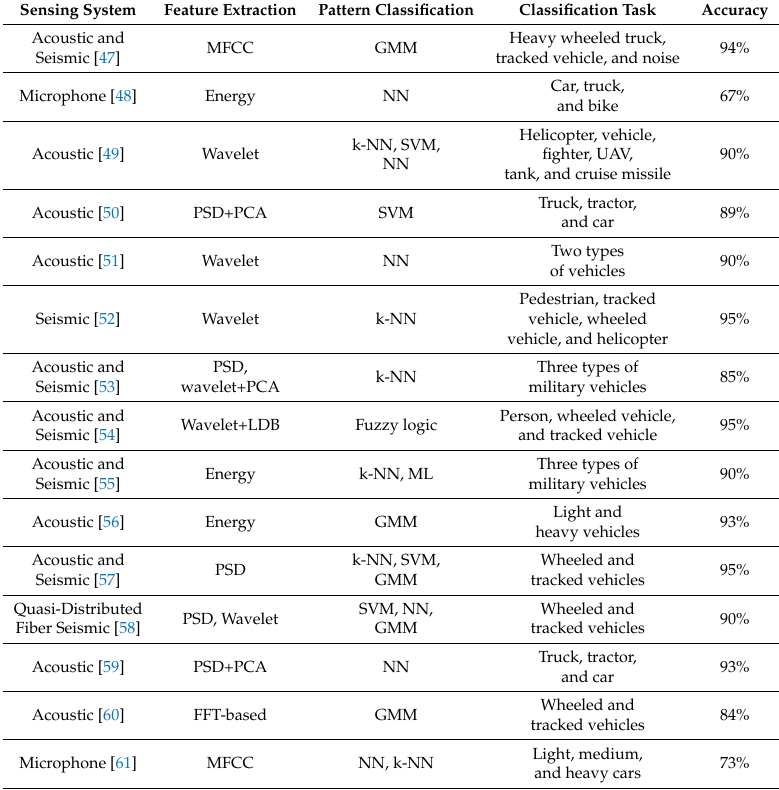
Table 1. Vehicle classification related work systems. ‘MFCC’ stands for Mel Frequency Cepstrum Coefficients, ‘FFT’ for Fast-Fourier Transform, ‘PSD’ for Power Spectral Density, ‘PCA’ for Principal Component Analysis, ‘LDB’ for Local Discriminant Bases, ‘NN’ for neural network, ‘k-NN’ for k-nearest neighbor, ‘GMM’ for Gaussian Mixture Model, ‘SVM’ for Support Vector Machine, ‘ML’ for Maximum Likelihood, and ‘UAV’ for Unmanned Aerial